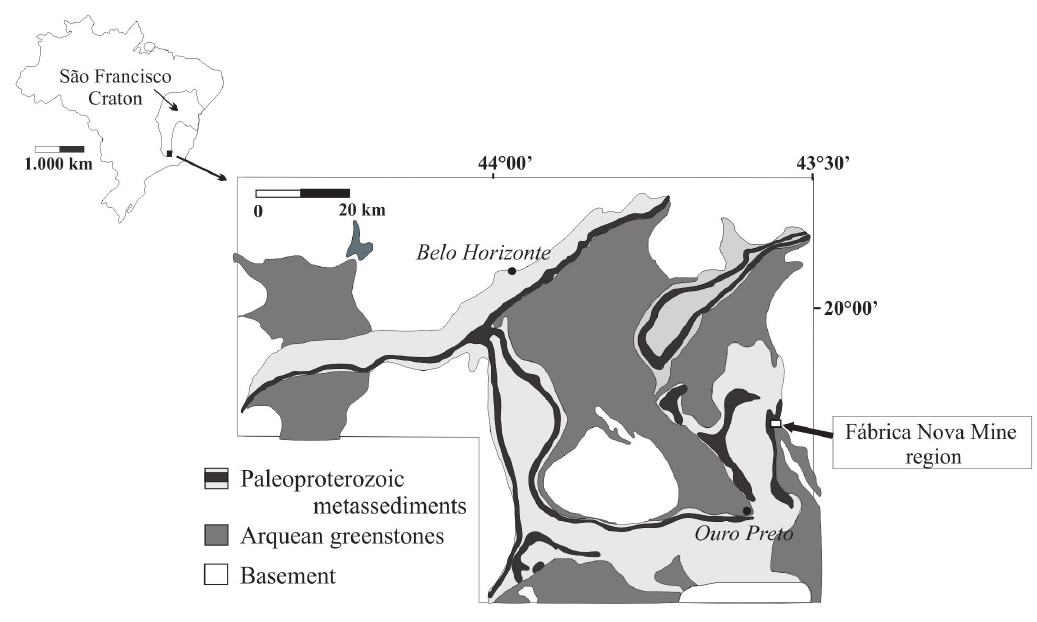
Figure 8 - Simplified geological map and the location of the Fábrica Nova Mine region in the Quadrilátero Ferrífero, Minas Gerais, Brazil (modified from Dorr